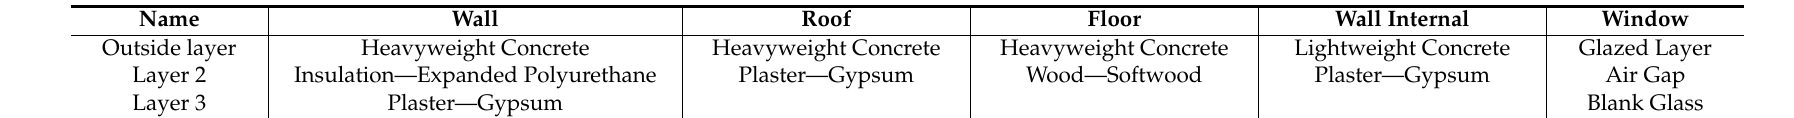
Table 3. Construction of each of the surfaces within the modeled